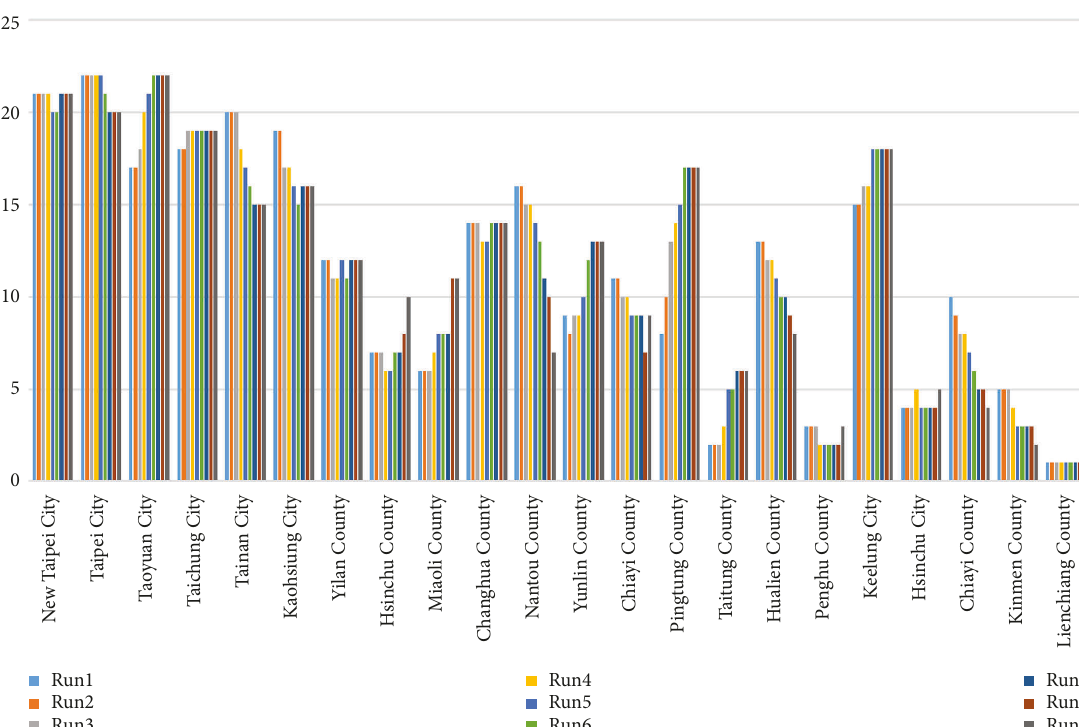
Figure 7: Sensitivity analysis: property-related crimes ( C